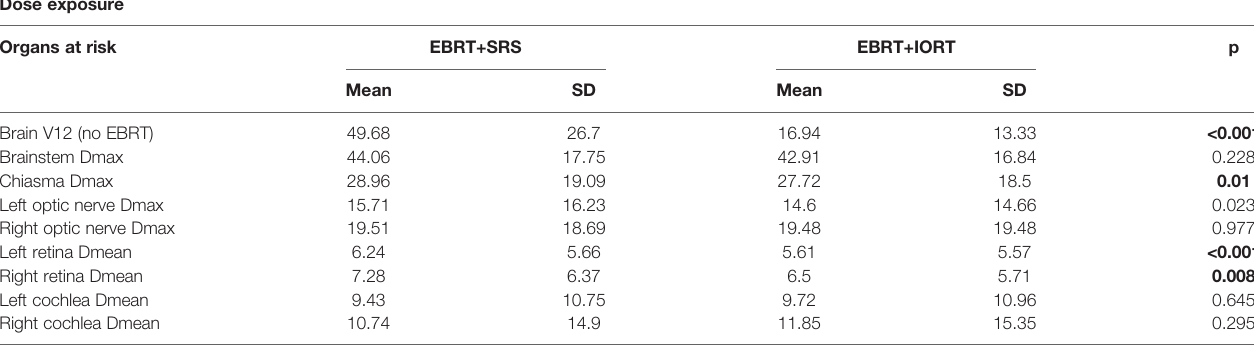
TABLE 2 | Organs at risk dosimetric differences.